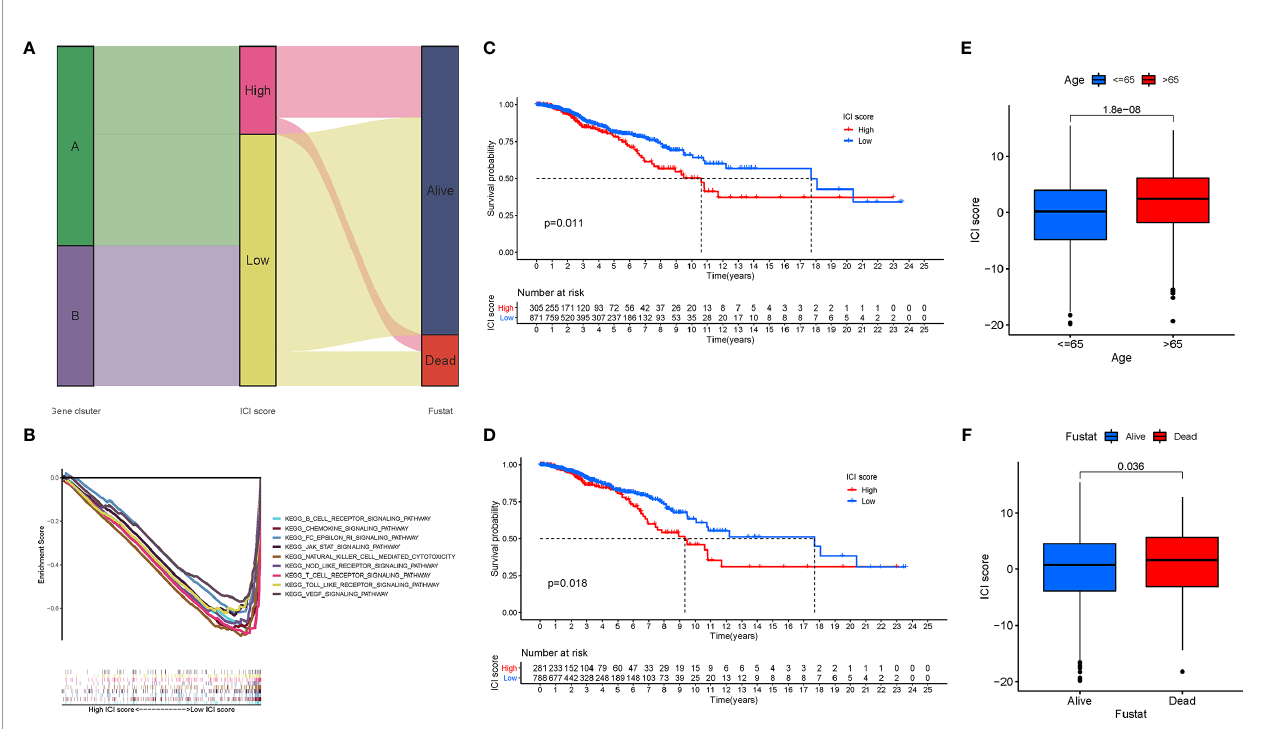
FIGURE 6 | Development of the ICI Scores. (A) Sankey diagram of ICI gene cluster distribution in subgroups with distinct ICI clusters, ICI scores, and survival status. (B) Enrichment plots showing B cell receptor, chemokines, JAK/STAT, Nod like receptor, and VEGF signaling pathways in the low ICI score subgroup. Kaplan-Meier curves for the high and low ICI score groups in the TCGA-BRCA cohort (C) and GSE58812 cohort (D) . (E) Comparison of ICI score between young (<=65) and old (>65) subgroups. (F) Comparison of ICI score between dead and alive